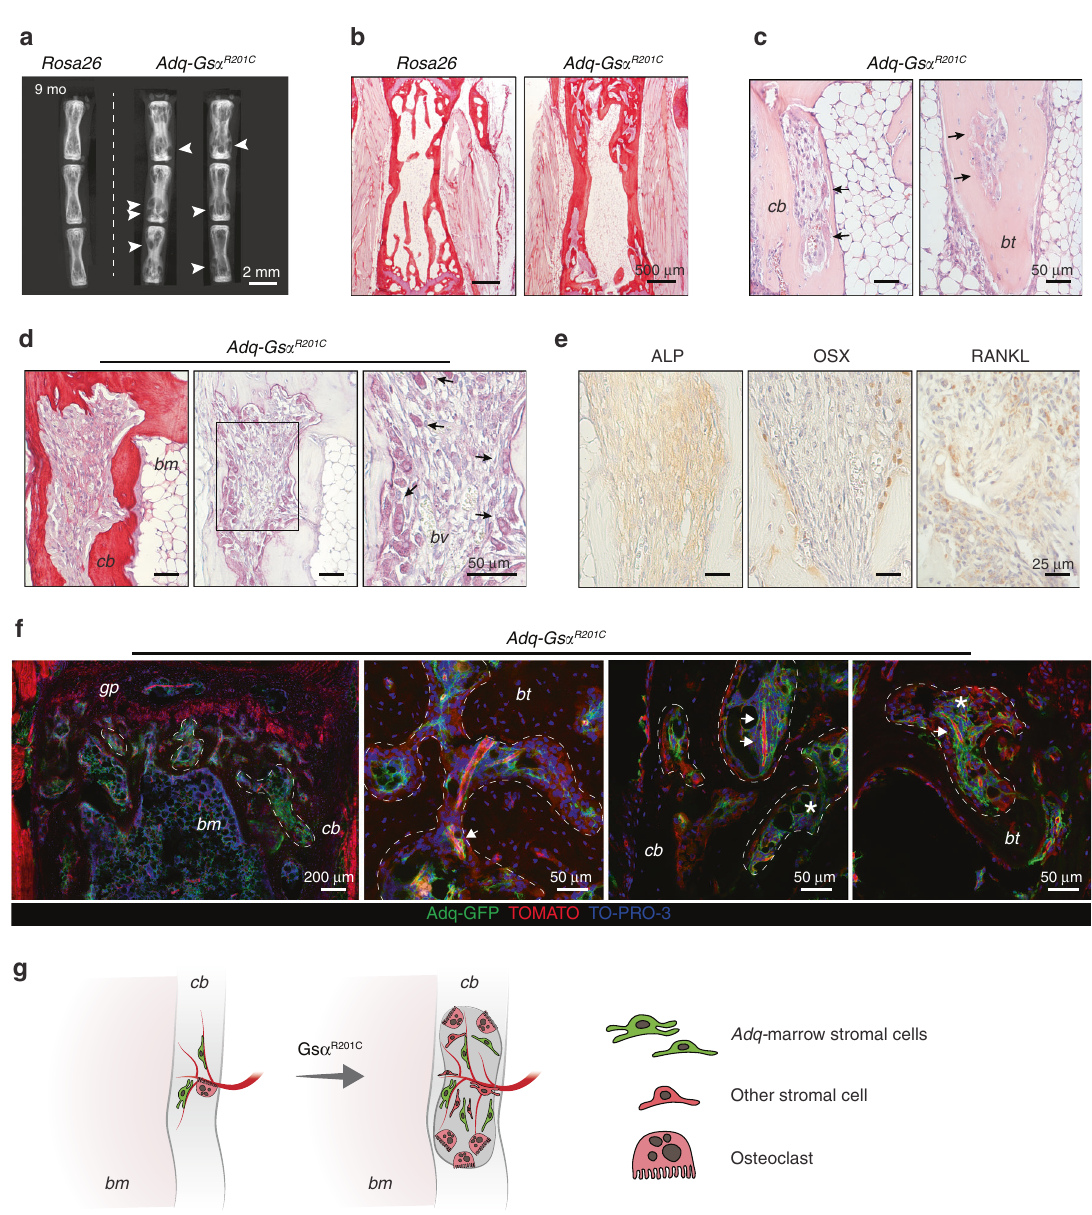
Fig. 8 Adq -intraosseous pericytes associate with lytic lesions in cortical and trabecular bone in Adq - Gs α R201C mice. a Radiographic analysis of dissected tail vertebrae from 9-month-old Rosa26 and Adq-Gs α R201C mice showing several osteolytic lesions ( arrowhead ). b Representative Sirius red stained sections of tail vertebrae from 9-month-old mice. c H&E-stained sections showing dissecting and tunneling resorption in tail vertebrae. Note the massive presence of osteoclasts ( black arrow ). d Sirius red and TRAP-stained sections showing intracortical bone resorption in tail vertebrae. Resorption areas progressed over time and were enriched in osteoclasts ( black arrow ) in close association with blood vessels ( bv ). e Immunolocalization of ALP, OSX and RANKL in a tail vertebra lytic lesion of Adq - Gs α R201C mice. f Representative confocal images from Adq-mTmG;Gs α R201C mice tail vertebrae showing areas of osteolysis ( dashed line ) fi lled with GFP-positive perivascular cells ( arrow ) and stromal cells ( asterisk ). g Schematic representation of lytic lesions associated with intracortical Gs α -mutated Adq -pericytes. cb : cortical bone, bt : bone trabecula, bm: bone marrow, gp : growth from the activation of Adq -stromal cells on the blood vessel exogenous hormone. Estrogen-dependent bone deposition in the abluminal side and involved the cortical endosteum only focally, marrow diaphysis is a long-known phenomenon in birds, as a consistent with the discontinuous distribution of Adq -cells at this physiological calcium storage mechanism during the egg-laying site. Thus, the topographic pattern of estrogen-dependent bone cycle, 24 and in female mice, as a non-physiological phenomenon formation in the diaphyseal cavity of Gs α R201C mice was rather induced by treatment with high doses of exogenous hormone. 25,26 However, estrogen-related medullary osteogenic processes pre- reminiscent of that observed in some estrogen-independent viously reported in birds and mice relied on the activation of cells experimental models of medullary osteogenesis, as for example, lining the endosteal surface and resulted in a centripetal process of in colchicine treated rats. 27,28 The reason why Adq -diaphyseal “ endosteal trabecularization ” . 25 In our Adq - Gs α R201C female mice perivascular marrow stromal cells require both Gs α R201C and and estrogen-treated male mice, the intra-medullary bone resulted estrogen to express their osteogenic potential remains to be